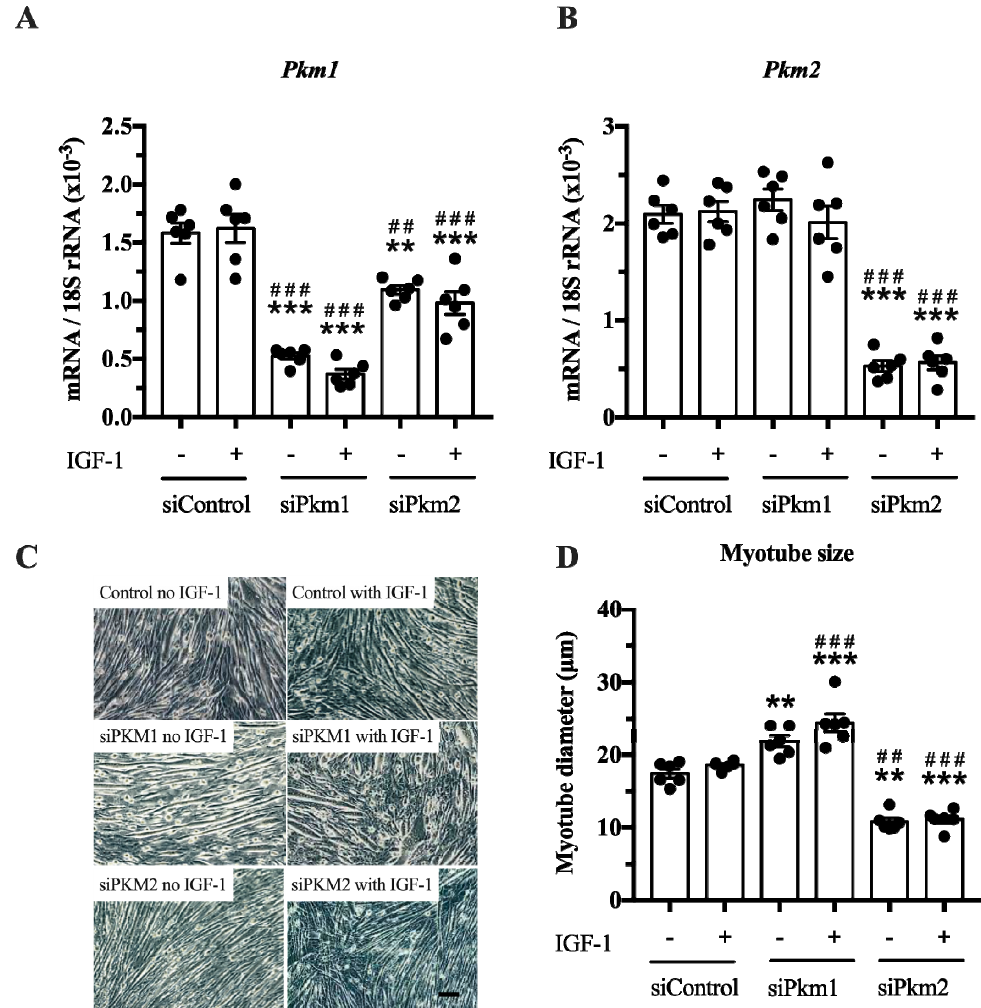
Figure 4. Effect of Pkm1 or Pkm2 knock down on C2C12 myotube size. ( A , B ) Pkm1 and Pkm2 mRNA expression following siRNA for Pkm1 and Pkm2 ( n = 5). ( C , D ) C2C12 myotube diameter after siRNA treatment for Pkm1 or Pkm2 ( n = 6). Scale bar is 100 µm. Black circles indicate individual data points. * Significantly different to unstimulated siControl ( p < 0.05) ; ** ( p < 0.01); *** ( p < 0.001)., # significantly